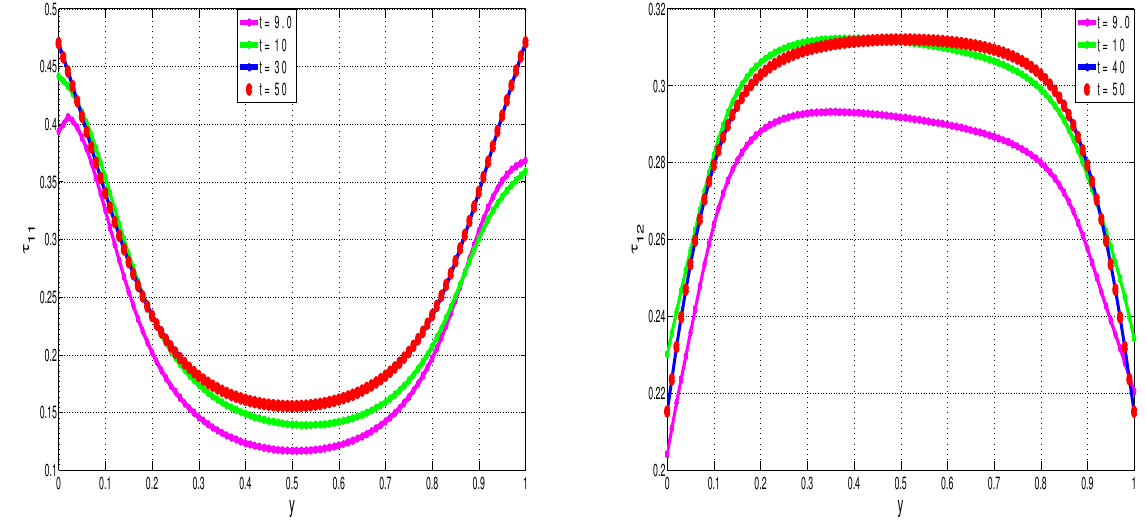
Figure 12. Development of steady polymeric-stress profiles with β = 0.95, ε = 2. τ 11 -stress ( left ) and τ 12 -stress ( right